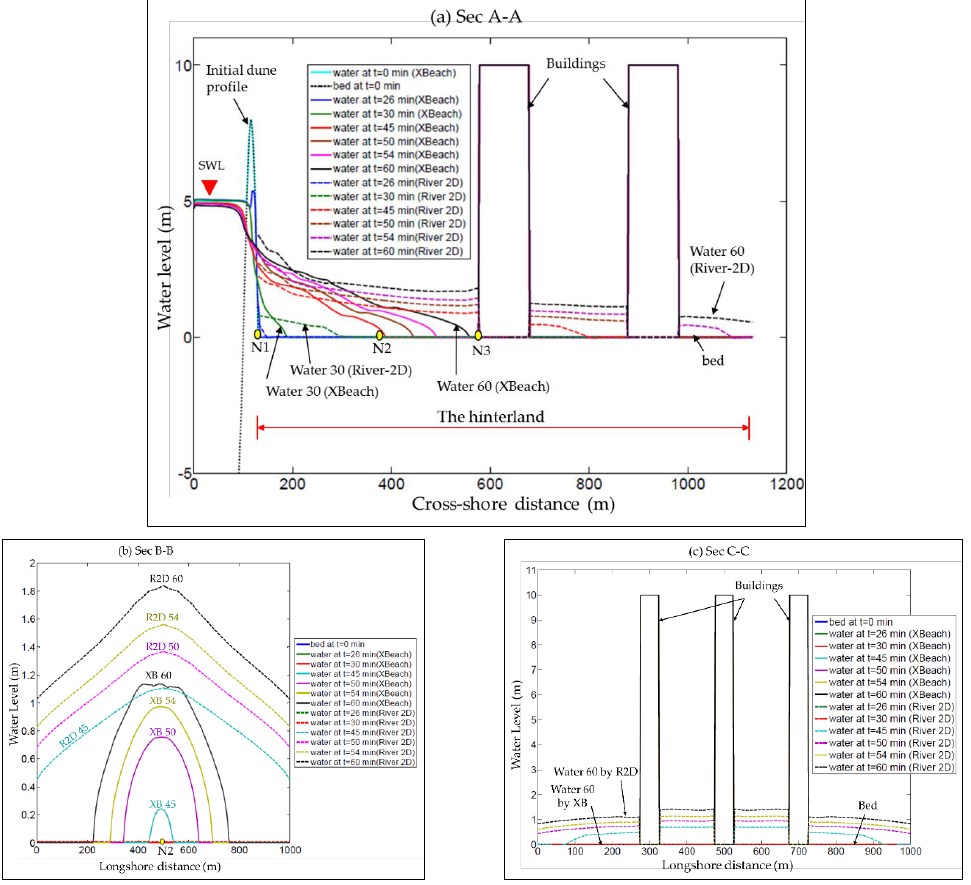
Figure 16. Comparison of the temporal evolutions of water depths by XBeach and River-2D at t = 26, 30, 45, 50, 54 and 60 min at ( a ) Sec A-A, ( b ) Sec B-B and ( c ) Sec C-C, showing higher predictions of water depths and flood extent by River-2D at all sections.